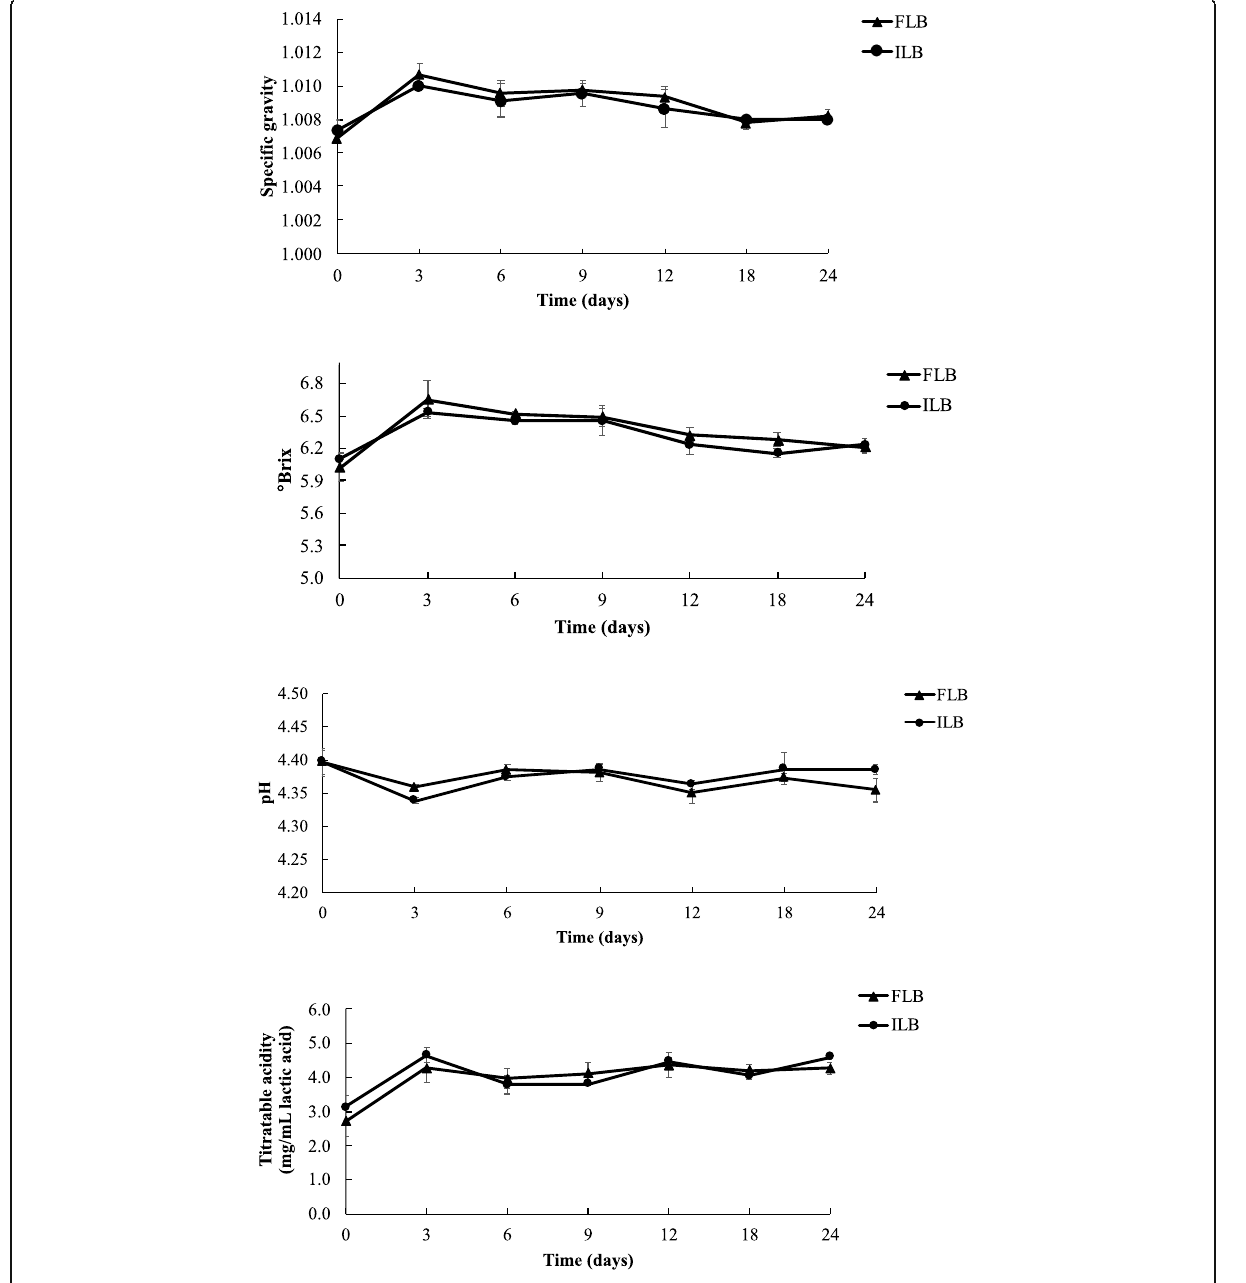
Fig. 5 Physico-chemical characteristics of beer with FLB and ILB. FLB = free L. brevis and ILB = immobilized L.